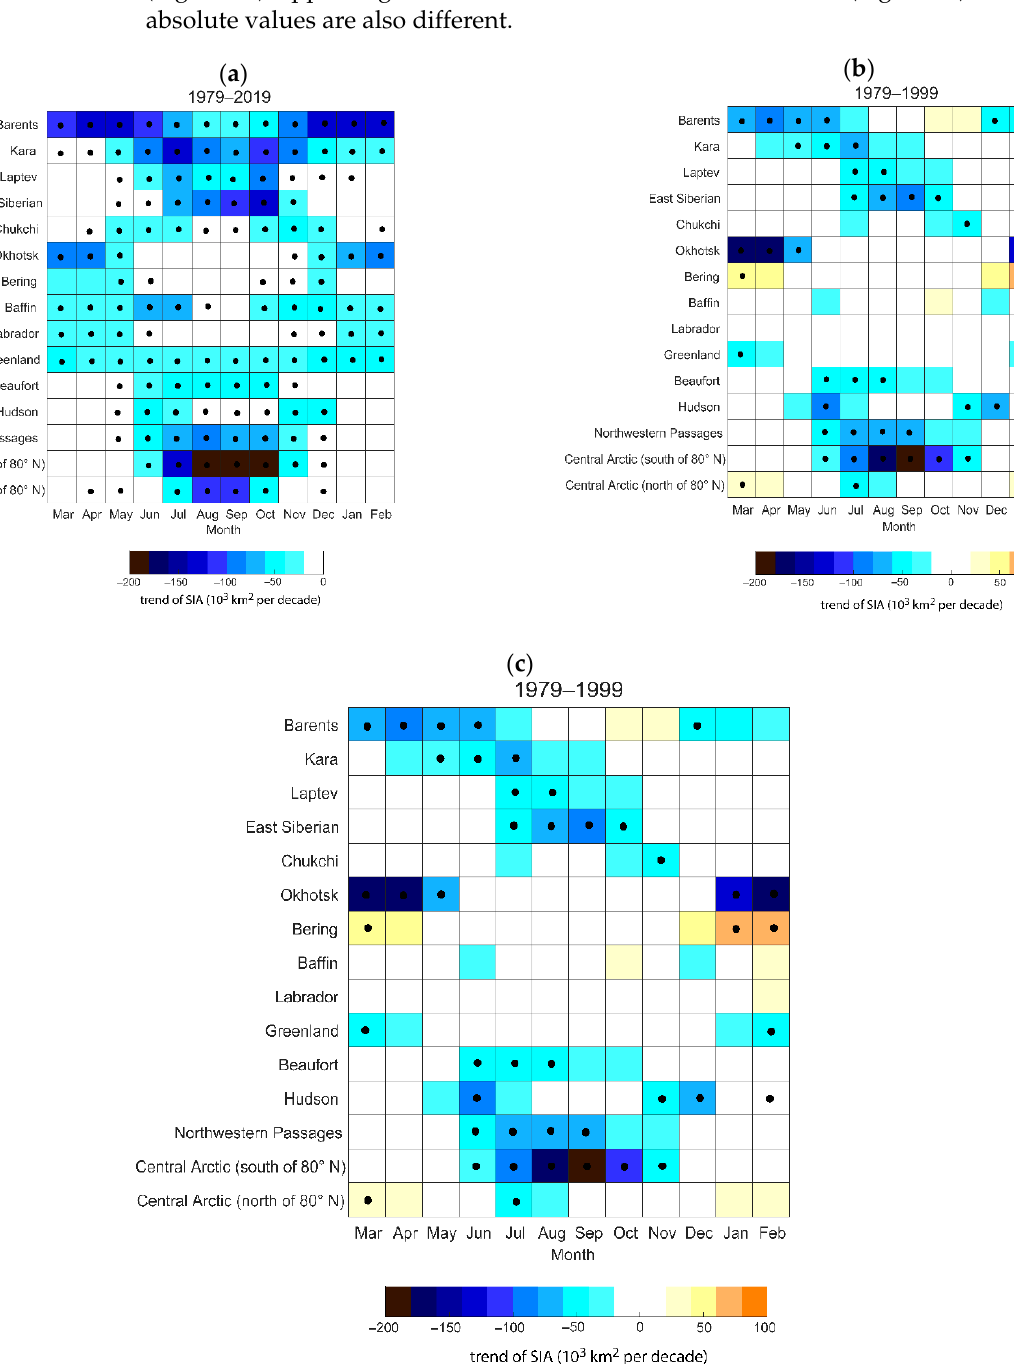
Figure 4. Trends for monthly SIA in ( a ) 1979–2019, ( b ) 1979–1999, and ( c ) 2000–2019. (Statistically significant (95% confidence level) trends are marked with dots, according Mann–Kendall Test).